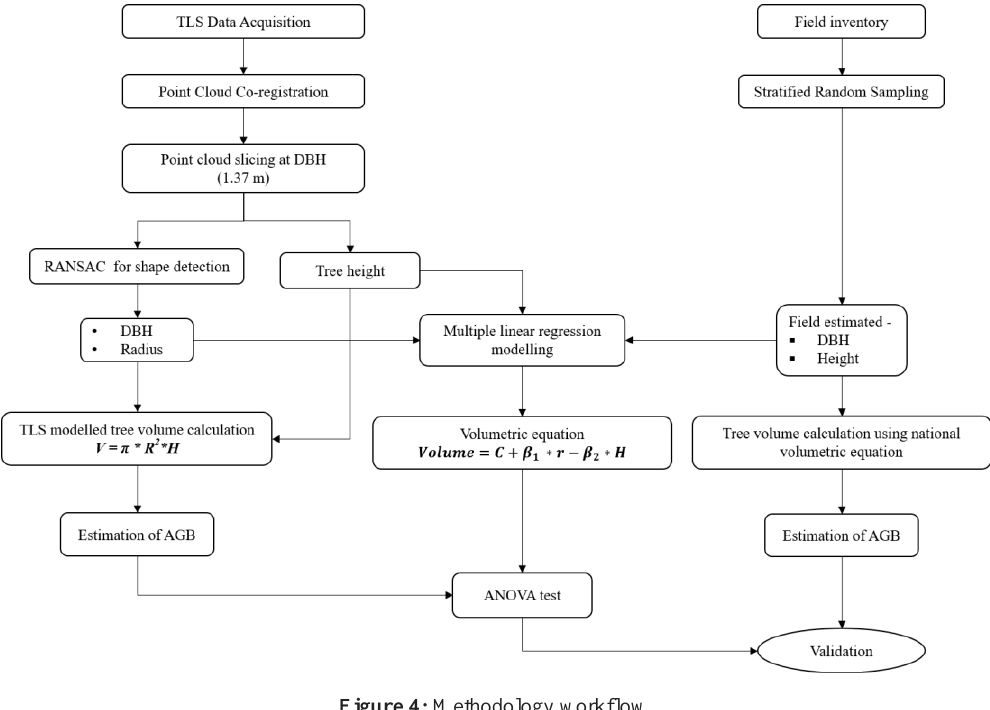
Figure 4: Methodology workflow.